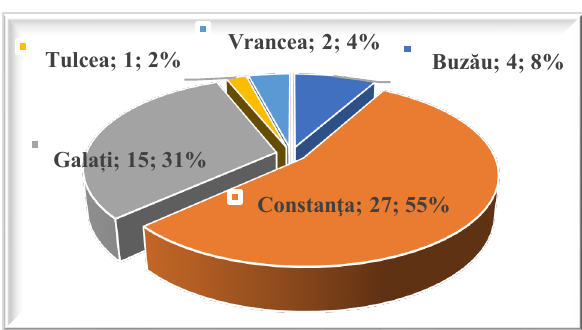
Figure 1. Intra-regional distribution of faculties operating in the South-East region in 2018-2019 academic